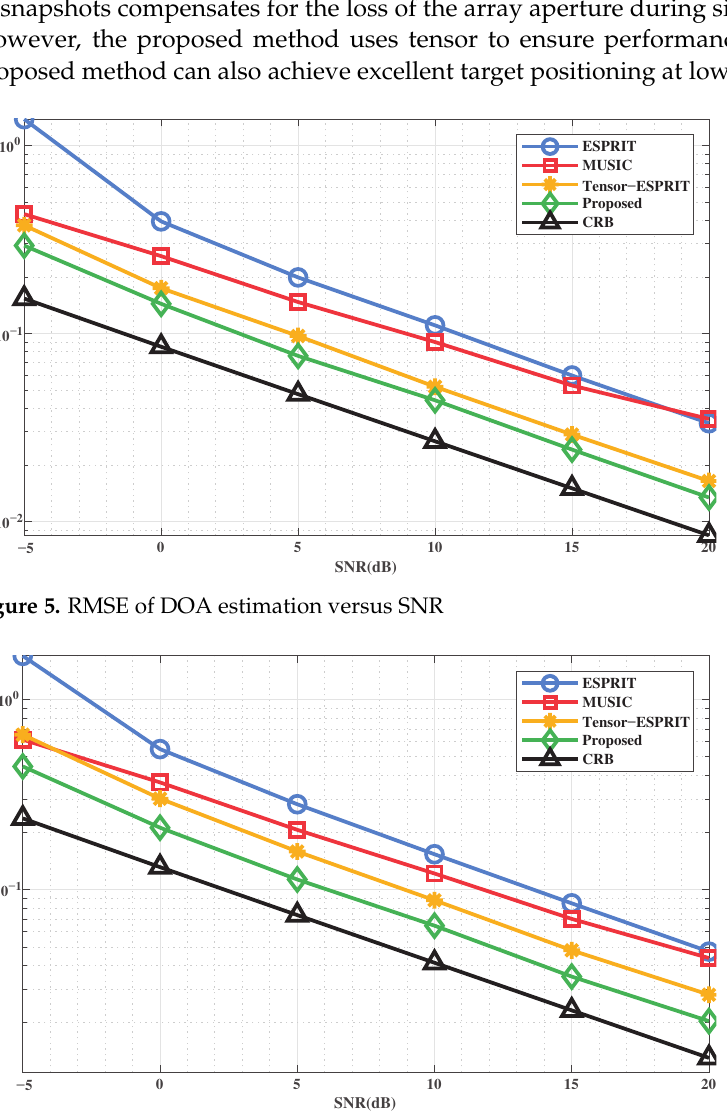
Figure 6. RMSE of range estimation versus